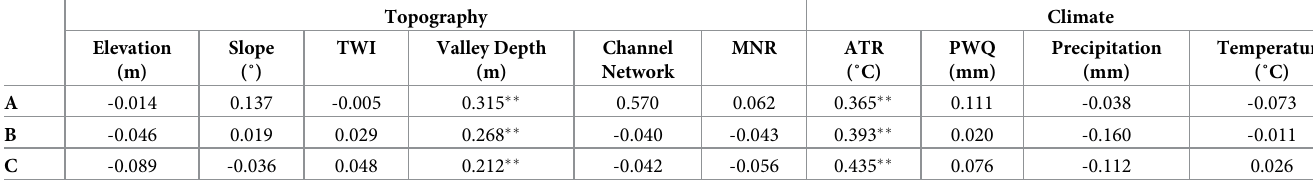
Fig 2. Differences in soil pH among parent materials in the horizons. Values with the same letter indicate no significant difference (p < 0.05). https://doi.org/10.1371/journal.pone.0218563.g002 samples with a mean pH of 6.05 were found in the areas with PWQ > 502 mm and TWI > 6.38. For the right sub-tree of the root, the samples were split by MNR. The samples with high values of soil pH were identified with MNR < = 5.42, and they were further split by elevation and valley depth. For the C horizon, the samples were also first split by parent mate- rial (Fig 4C). The samples collected from Cambrian, Jurassic, Ordovician, Triassic, and Juras- sic limestone had higher soil pH than did the samples from Silurian marlite and Permian limestone. This condition was the same as that for the B horizon. In level 2, ATR, PWQ, and Table 3. Pearson correlation between pH and topographic indicators and climate